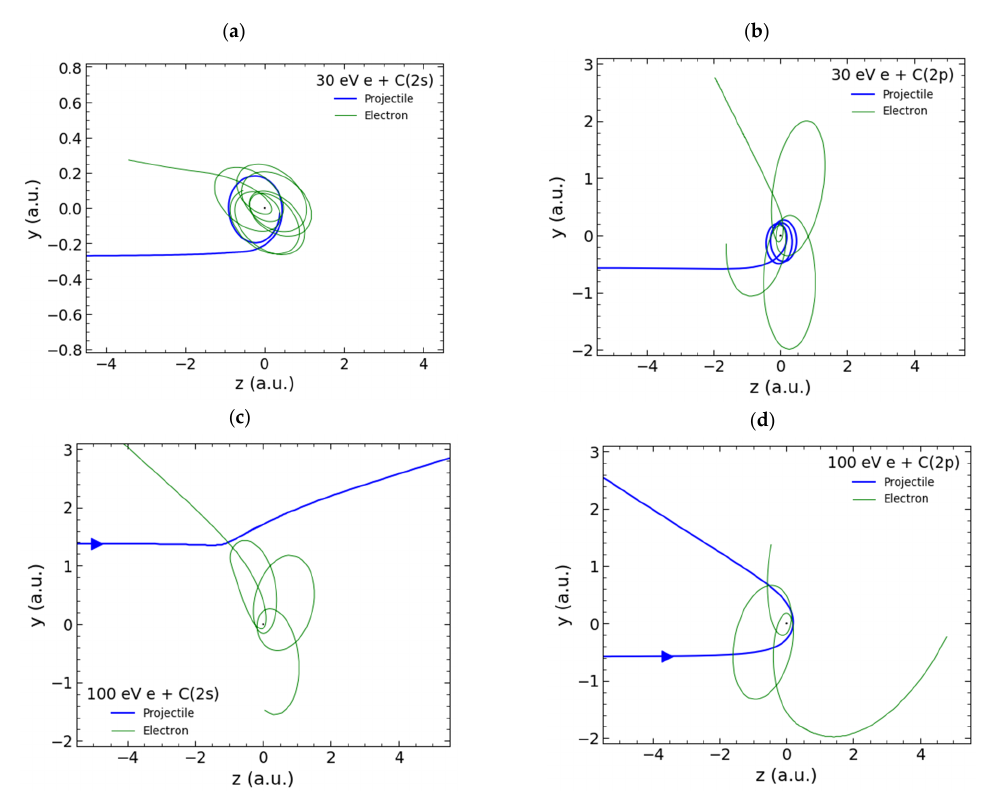
Figure 4. Ionization cross-section as a function of incident energy. Expt.: filled dots: Brook (Ref. [3]). Theories: dash-dotted-blue-line: DWBA in the potential of the ionizing ion (Ref. [18]), dotted-green- line: DWBA in the potential of the ionized ion (Ref. [18]), solid-red-line: present CTMC results using the standard addition rule, dotted-red-line: B-CTMC.